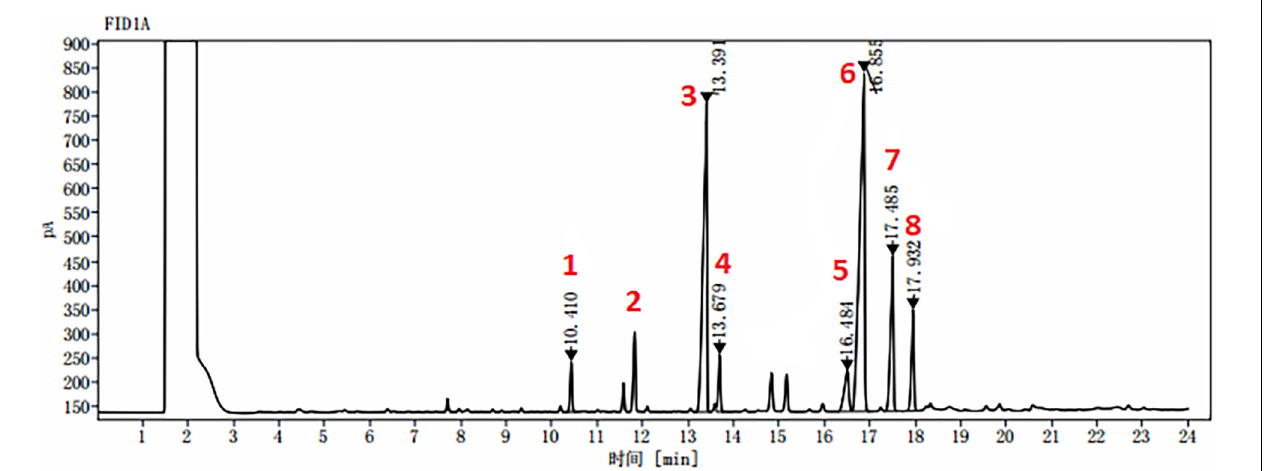
FIGURE 7 | A typical GC chromatogram of target FAs identified from all tested samples. 1 . myristic acid “C14:0” at retention time: 10.410 min; 2 . pentadecanoic acid as standard “C15:0” at retention time: 11.910 min; 3 . palmitic acid “C16:0” at retention time: 13.391 min; 4 . palmitoleic acid “C16:1” at retention